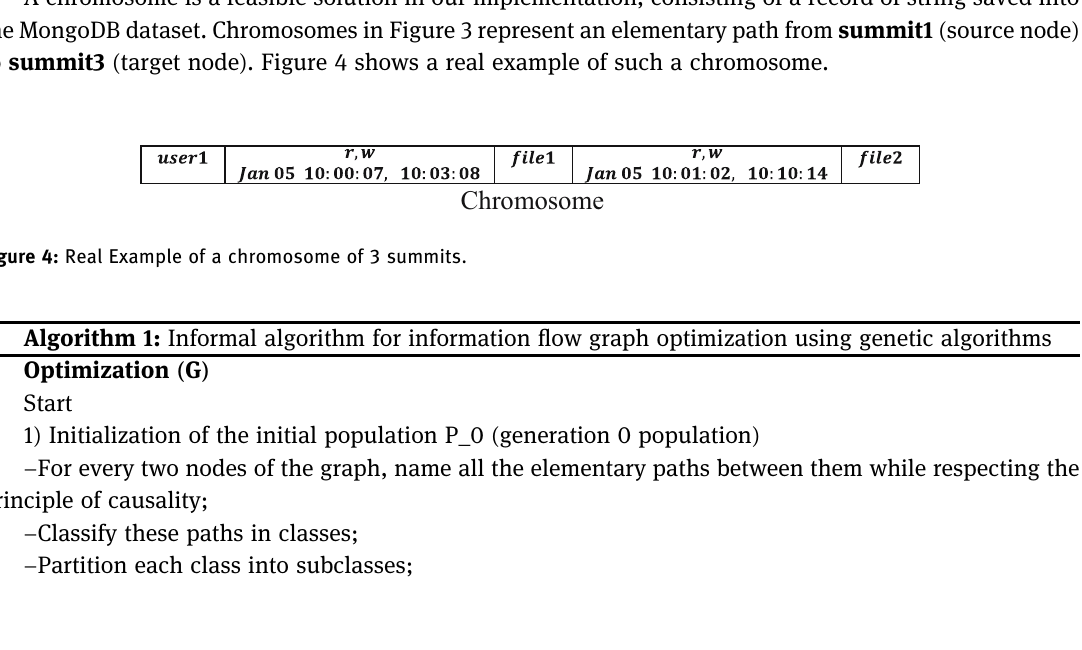
Figure 3: Chromosome representation for an elementary path of 3 summits.